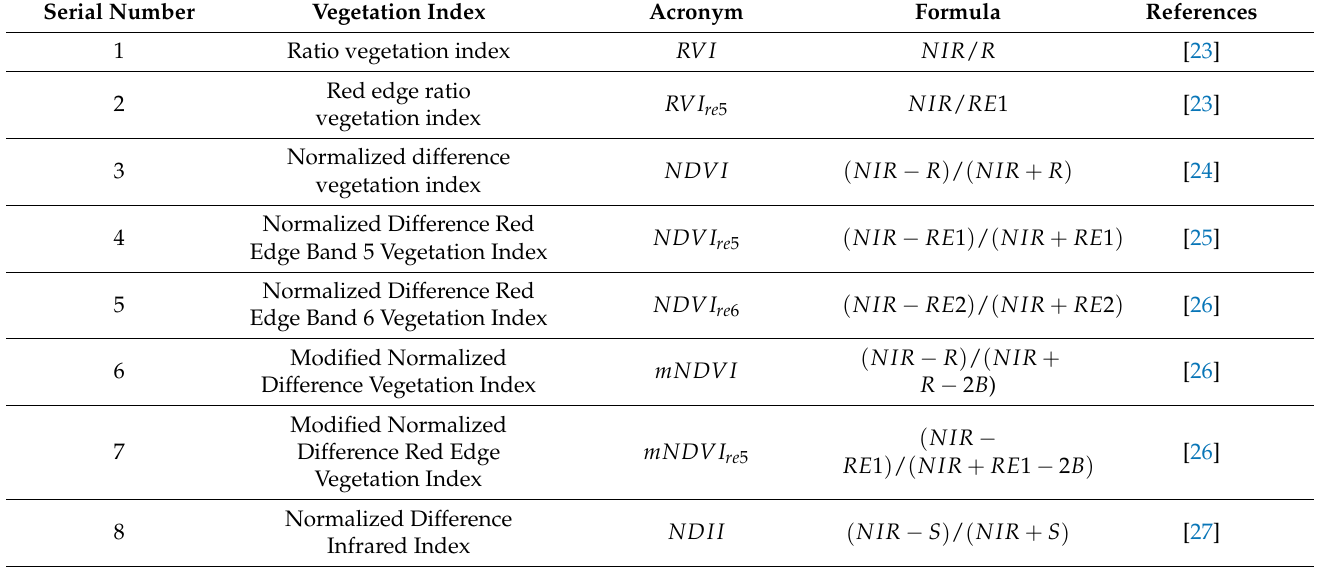
Table 3. Appropriate vegetation indices for Sentinel image